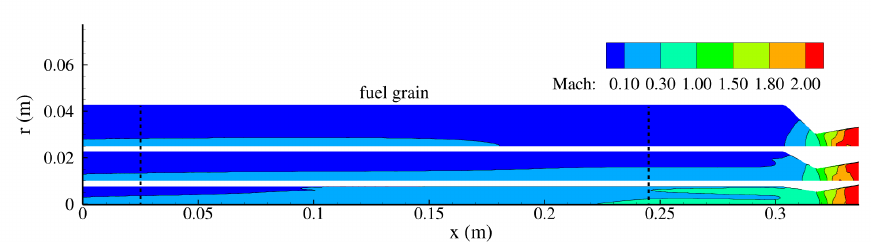
Figure 6. Mach number contours for test 4 of set 1 at different port diameters.